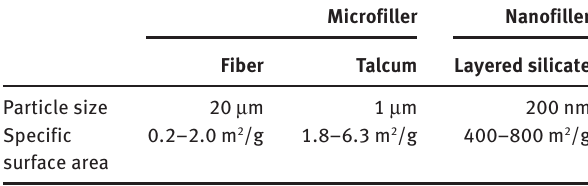
Table 1 Specific surface areas of fillers [9] .